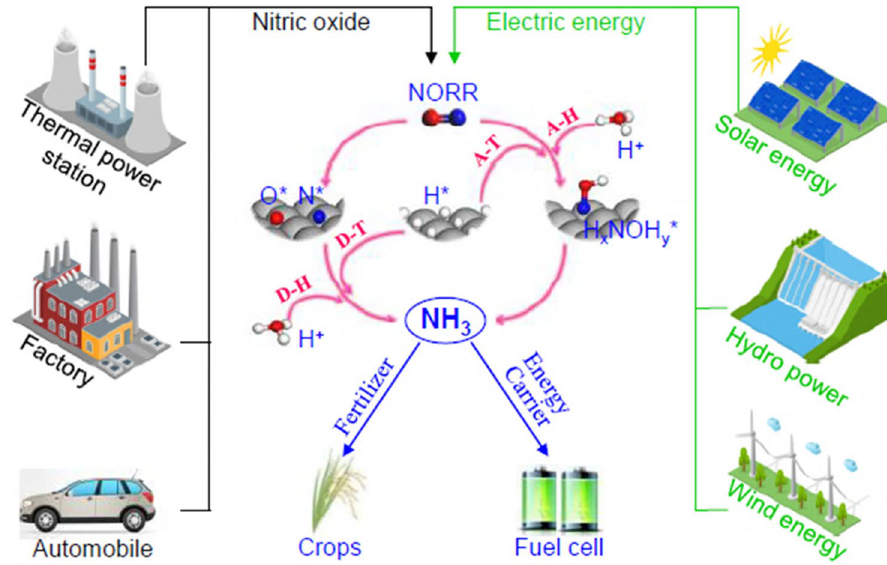
Fig. 12 Illustration of the proposed electrochemical ammonia synthesis route from NO from Ref.